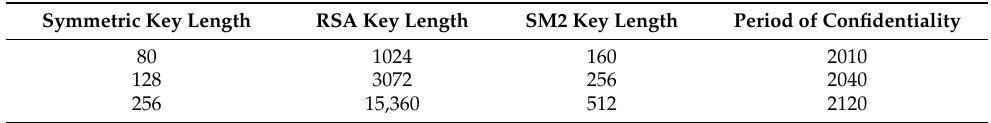
Table 1. The table of key strength